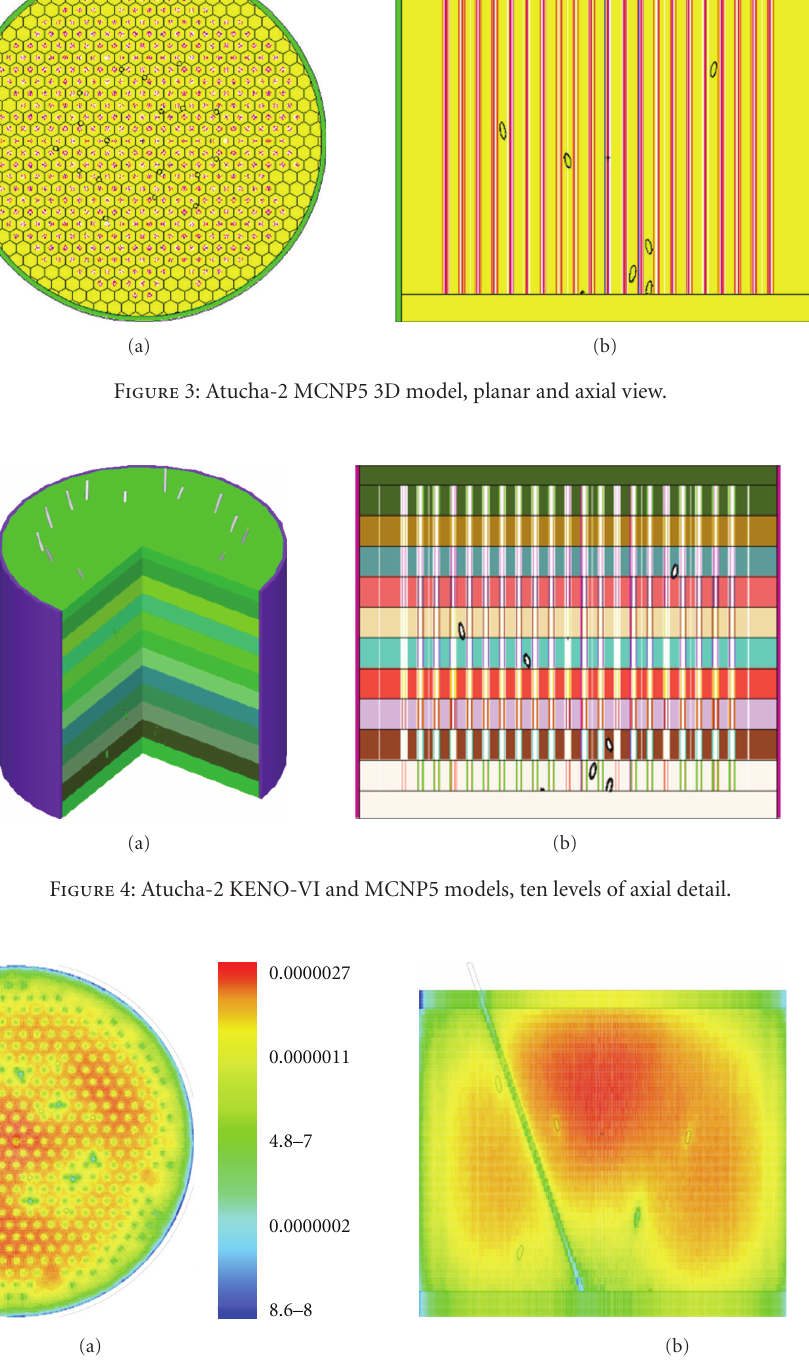
Figure 5: Results from the Atucha-2 MCNP5 3D model-thermal Flux distribution, planar and axial view.